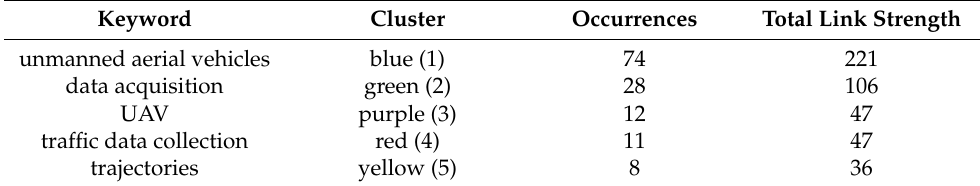
Table 2. The top keywords co-occurrence and total link strength.